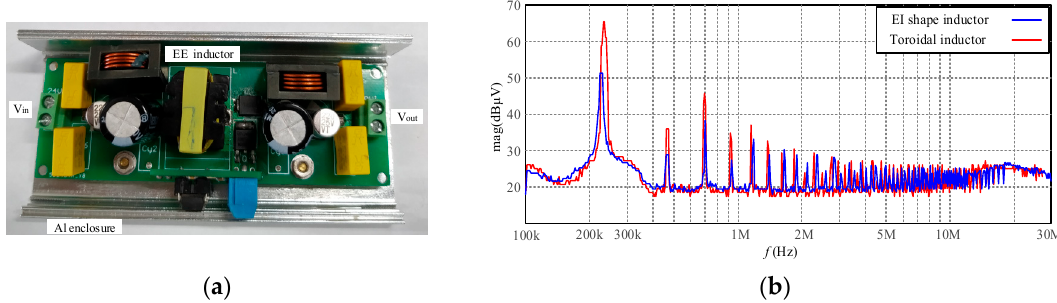
Figure 12. EE shaped inductor and CM conducted emission ( a ) boost using EE shaped inductor; ( b ) CM conducted emission with different inductors.